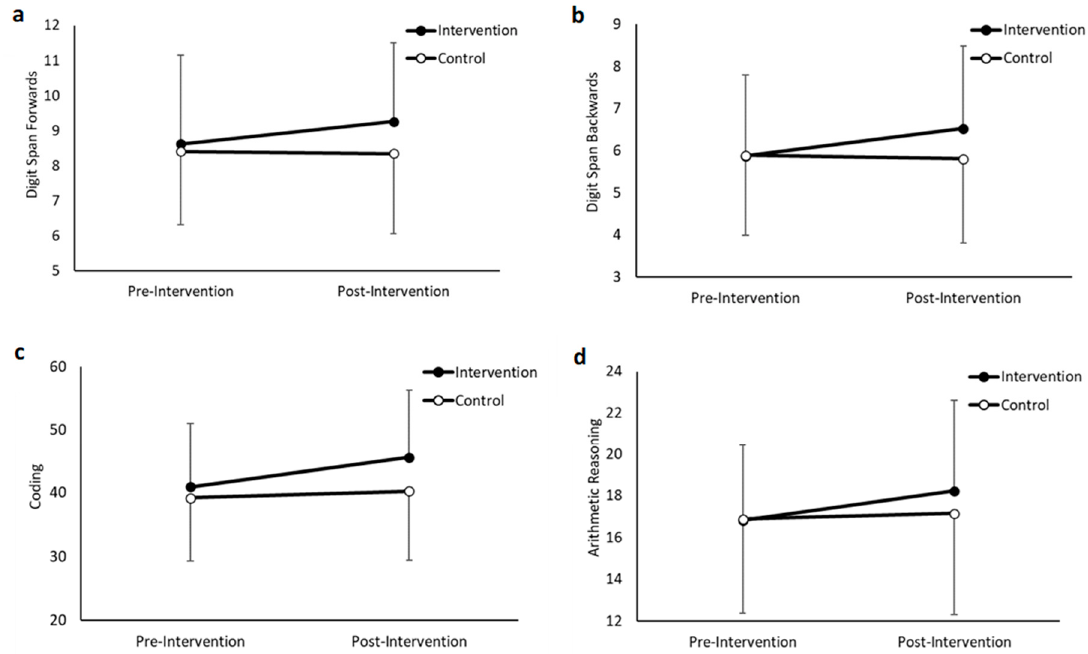
Figure 2. Performance on the cognitive function tests, pre- and post-intervention, in the intervention and control groups (data are mean ± SD). ( a ): Digit Span Forwards, group * time, p = 0.0.23; ( b ): Digit Span Backwards, group * time, p = 0.008; ( c ): Coding, group * time, p = 0.012; ( d ): Arithmetic Reasoning, group * time, p = 0.022.